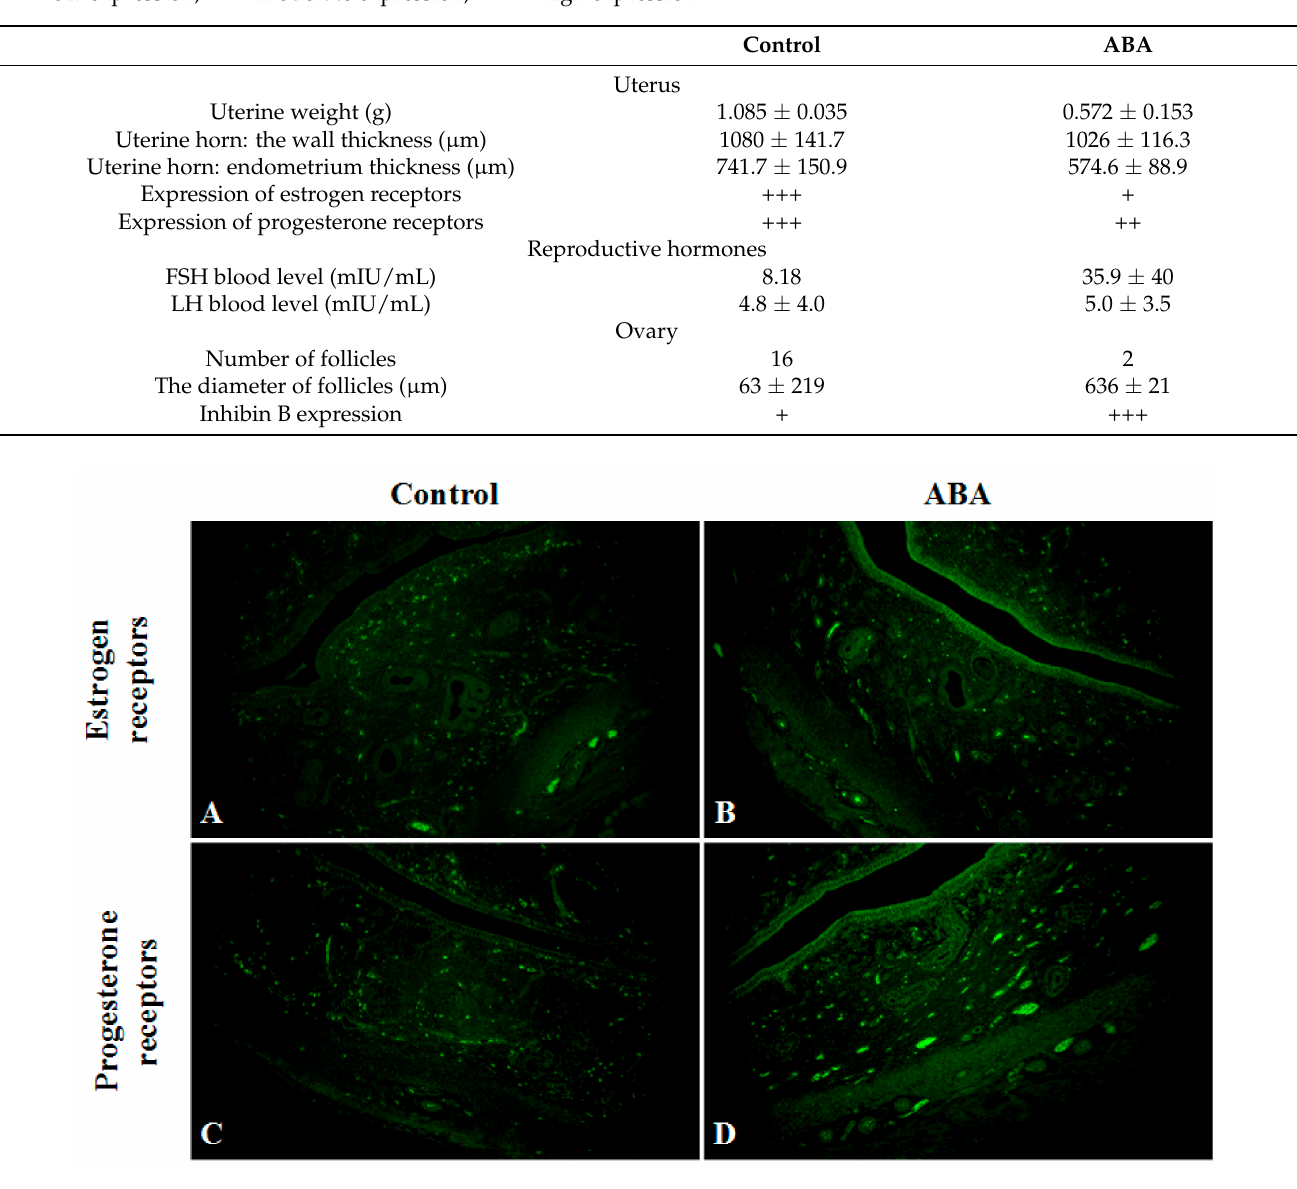
Figure 7. Uterine horn in the control group ( A , C ) and ABA ( B , D ) group stained for estrogen (green, Alexa Fluor 488) and progesterone (green, Alexa Fluor 488) receptors. Expression of both receptors in the endometrium of ABA rats is reduced. Total magnification: ×